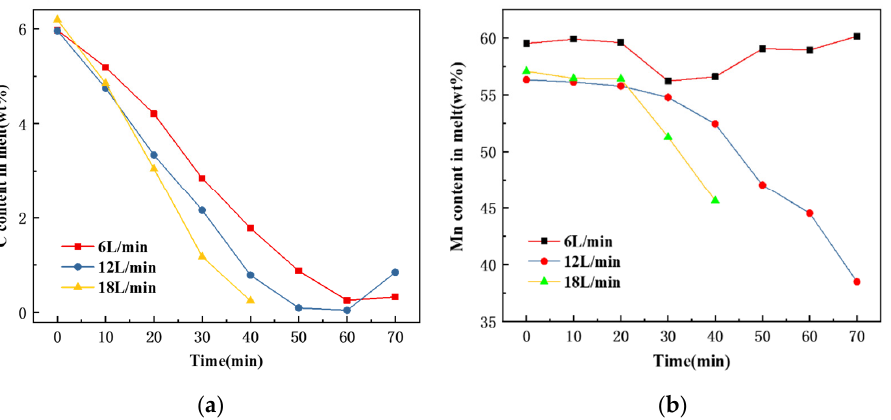
Figure 2. Variations of carbon and manganese contents in melt with time by blowing O 2 in different flow rates: ( a ) carbon; ( b ) manganese.